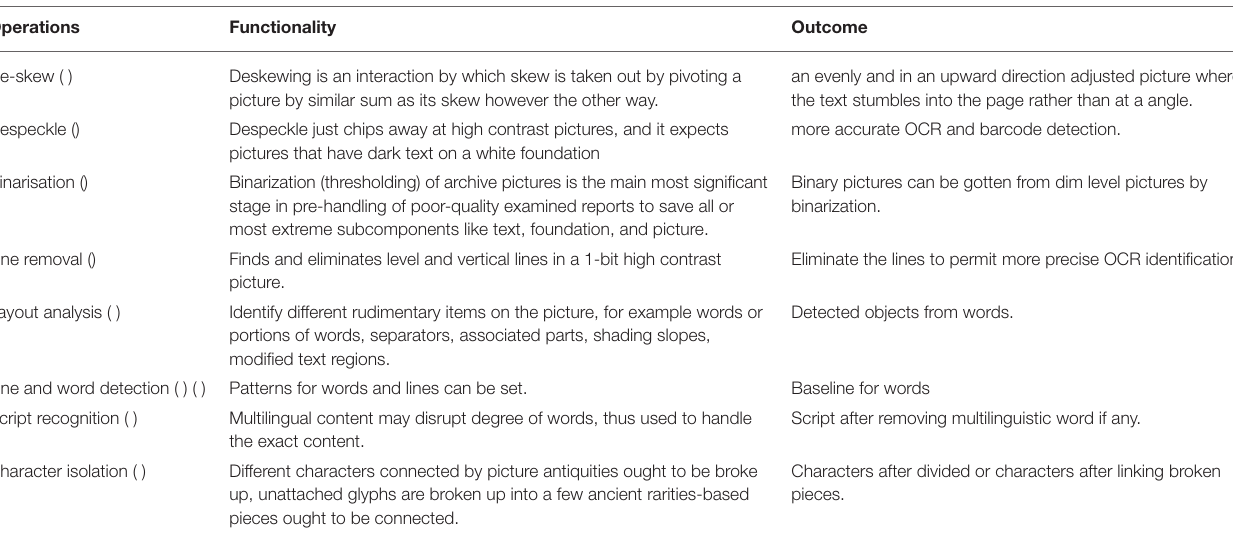
TABLE 2 | Pre-processing technique